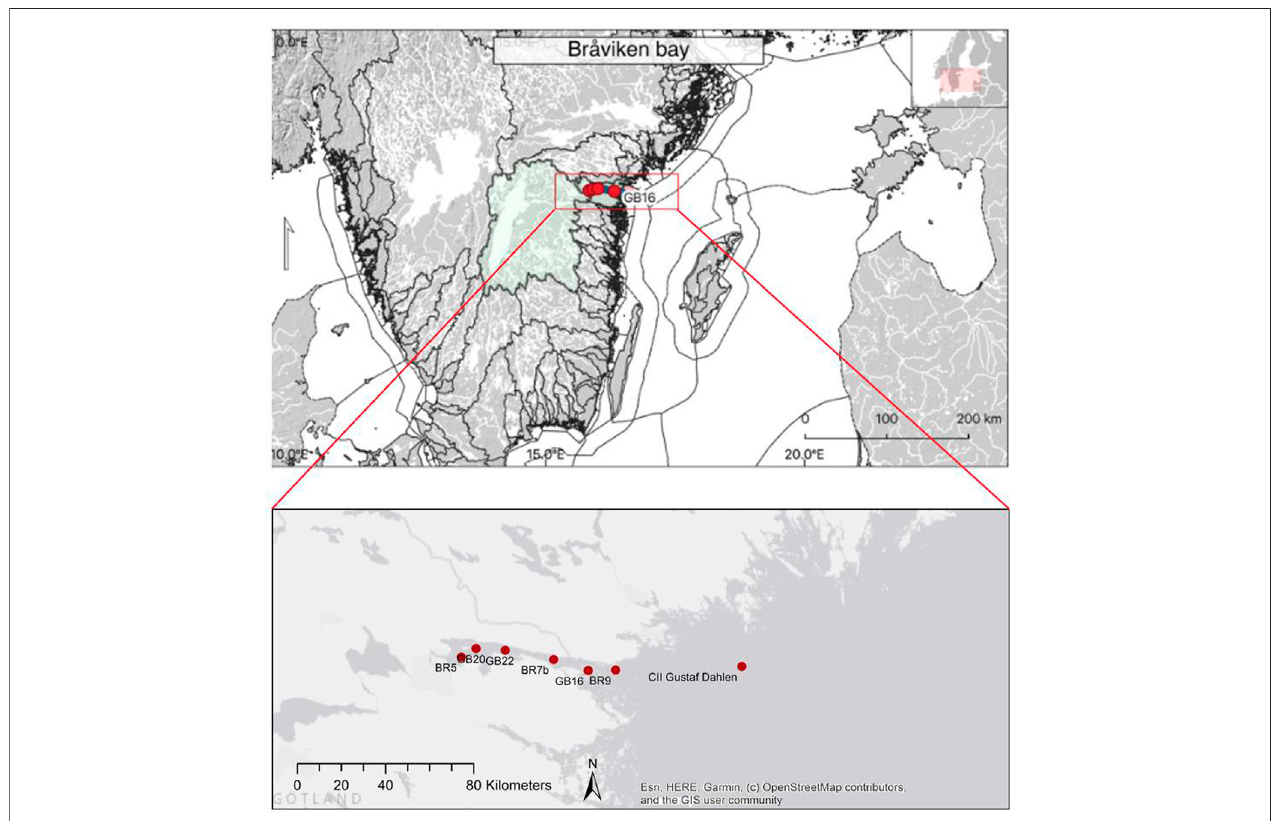
FIGURE 1 | Bråviken bay is situated in the NW Baltic proper. Eight stations were sampled in total; station GB16 was sampled twice: during 1 July 2021, on the transect into the bay, and during 2 July 2021, on the transect out ofthe bay. The overview map (upper panel) wastaken from Kratzer et al. (2019, Figure 1 upper panel, license agreement CC BY